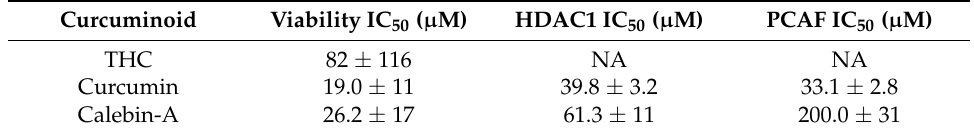
Table 2. The potency of curcuminoids on Sup-T1 growth inhibition and HDAC1/PCAF